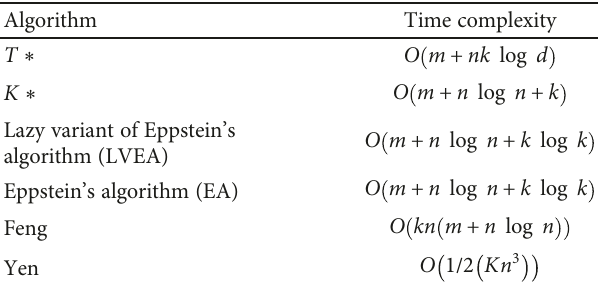
Table 1: Time complexity of T ∗ , K ∗ , Yen, Feng, EA, and LVEA algorithms. As shown in the Table 1, the T ∗ algorithm has better computational performance in terms of running time when compared to others